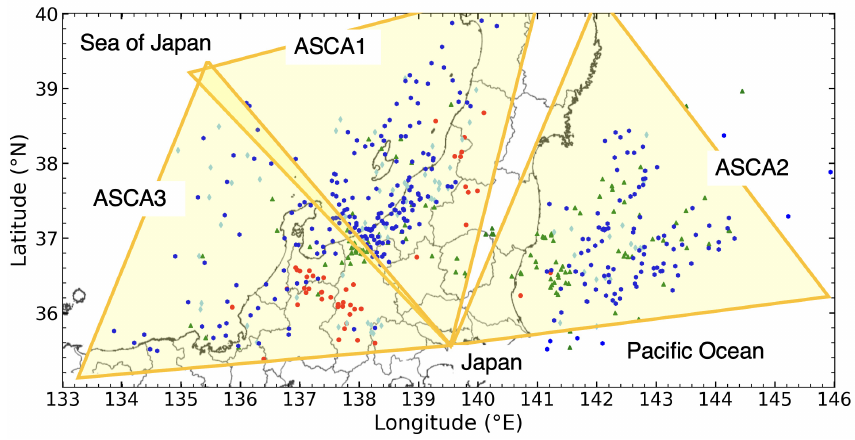
Figure 4. Field of view of the three ASCA cameras. Spring, summer, autumn, and winter are represented by green triangles, red dots, light blue diamonds, and blue dots,